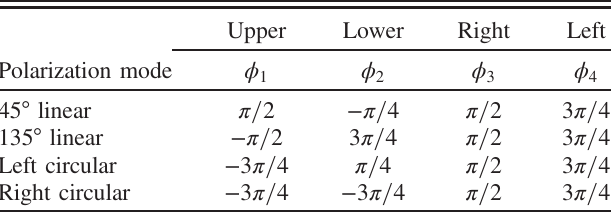
TABLE I. Phase shifts of magnet arrays for different polariza- tion modes in the Fig. 8 AMPU.